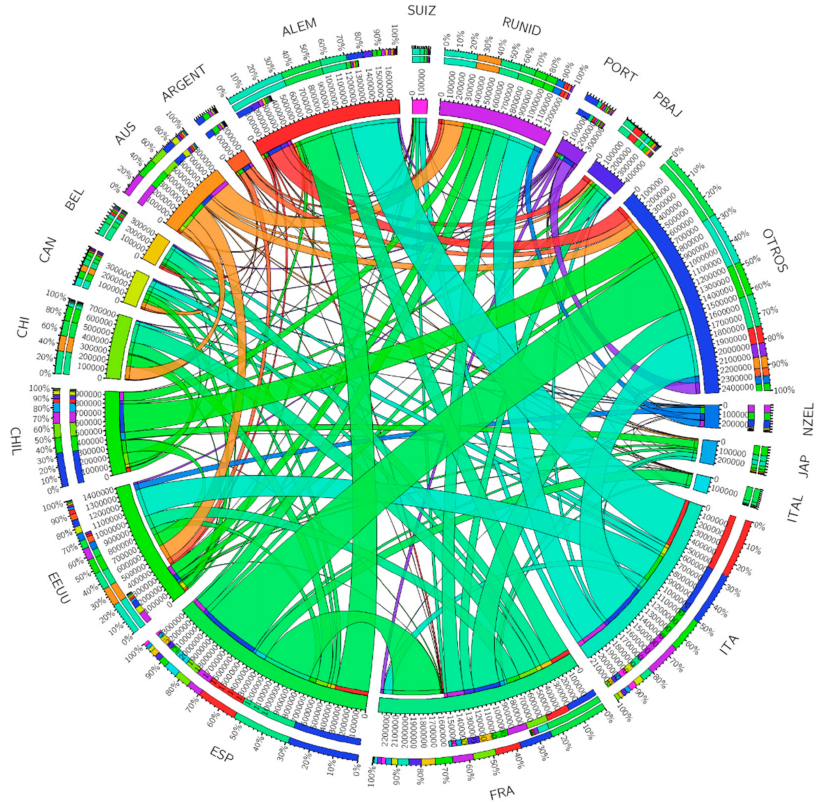
Figure 1. World wine trade. Volume. 2017 (Tm). Source